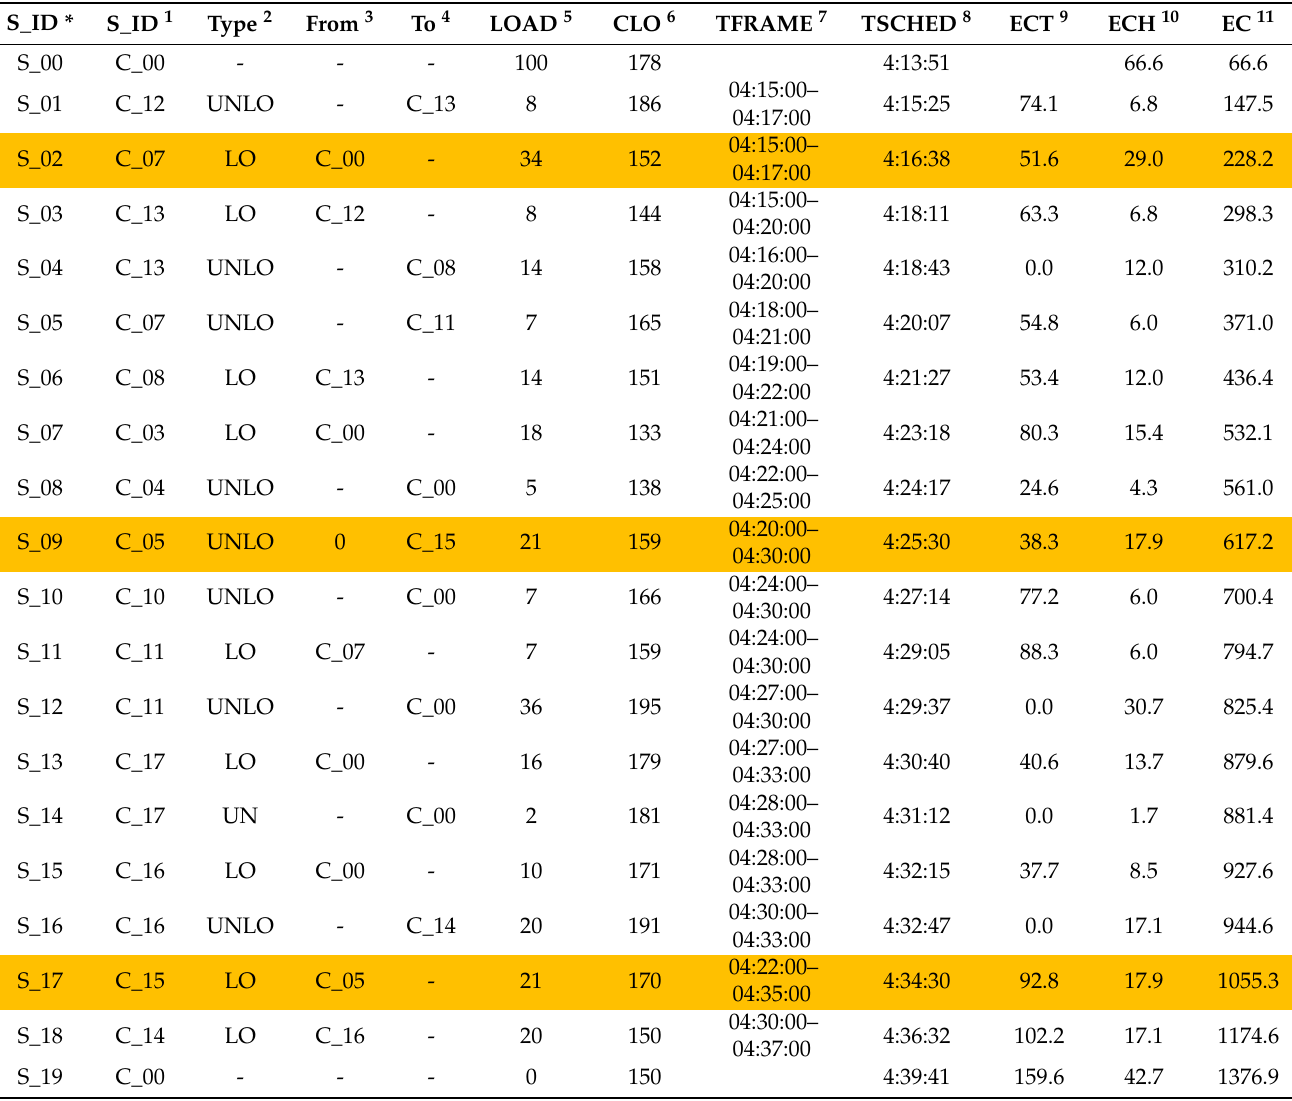
Table 11. Numerical results of the scheduling of predefined and real-time-generated specific in-plant material supply operations performed by the milk-run trolley within route 3. The colored rows represent the real-time added supply demands generated by the supervisory level using the results of the optimization based on the digital twin